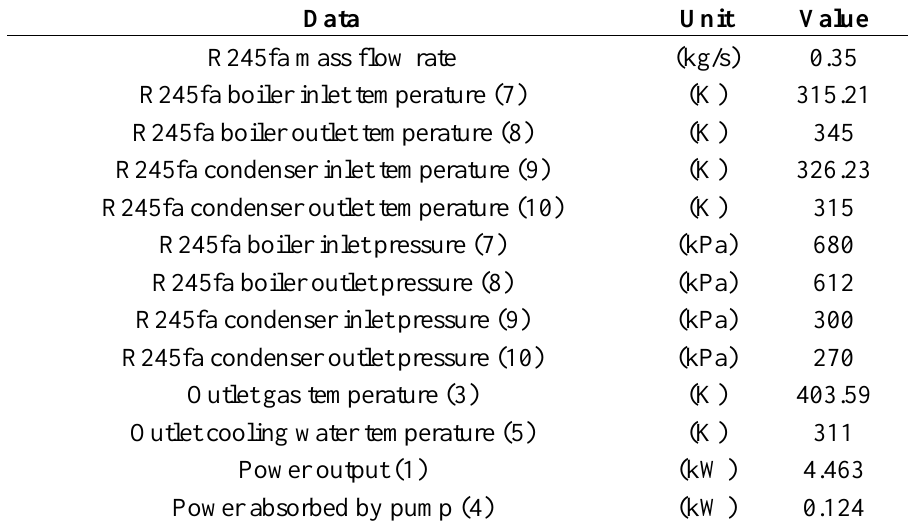
Table 4. Simulation results of the R245fa